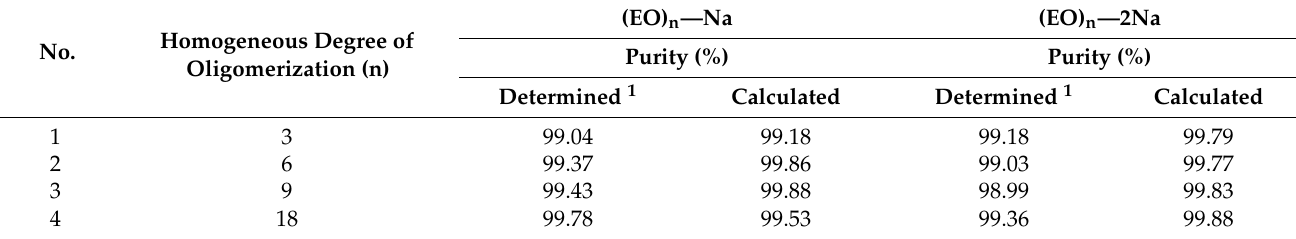
Table 10. The main chemical characteristics of several homogeneous polyoxyethylene chains (EO) n n = 3, 6, 9, 18, (EO) n -Na) and (EO) n